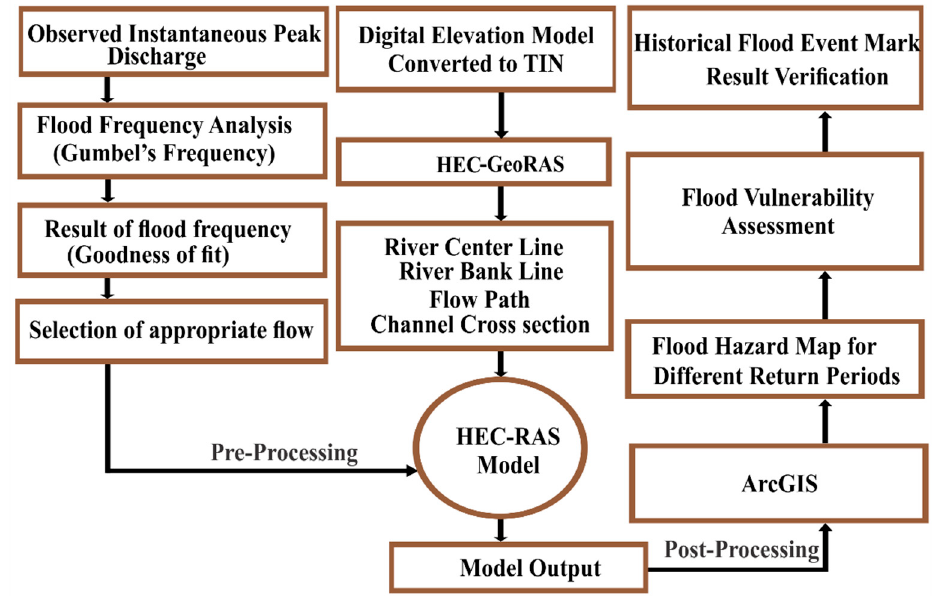
Figure 5. Flowchart of the flood inundation modeling in this study.